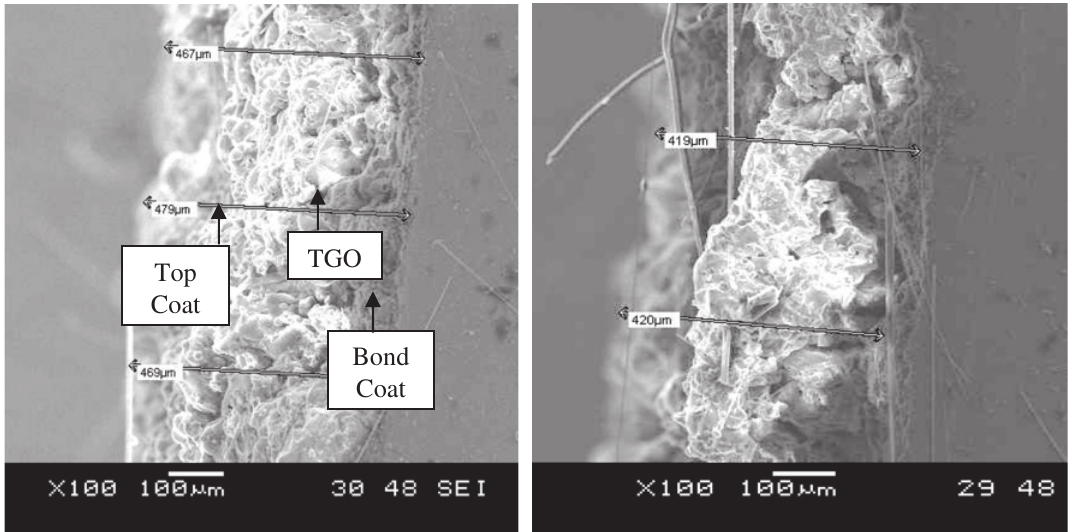
Figure 3: (a) Cross section of Ce 2 Zr 2 O 8 , (b) NiCrAlY interface.